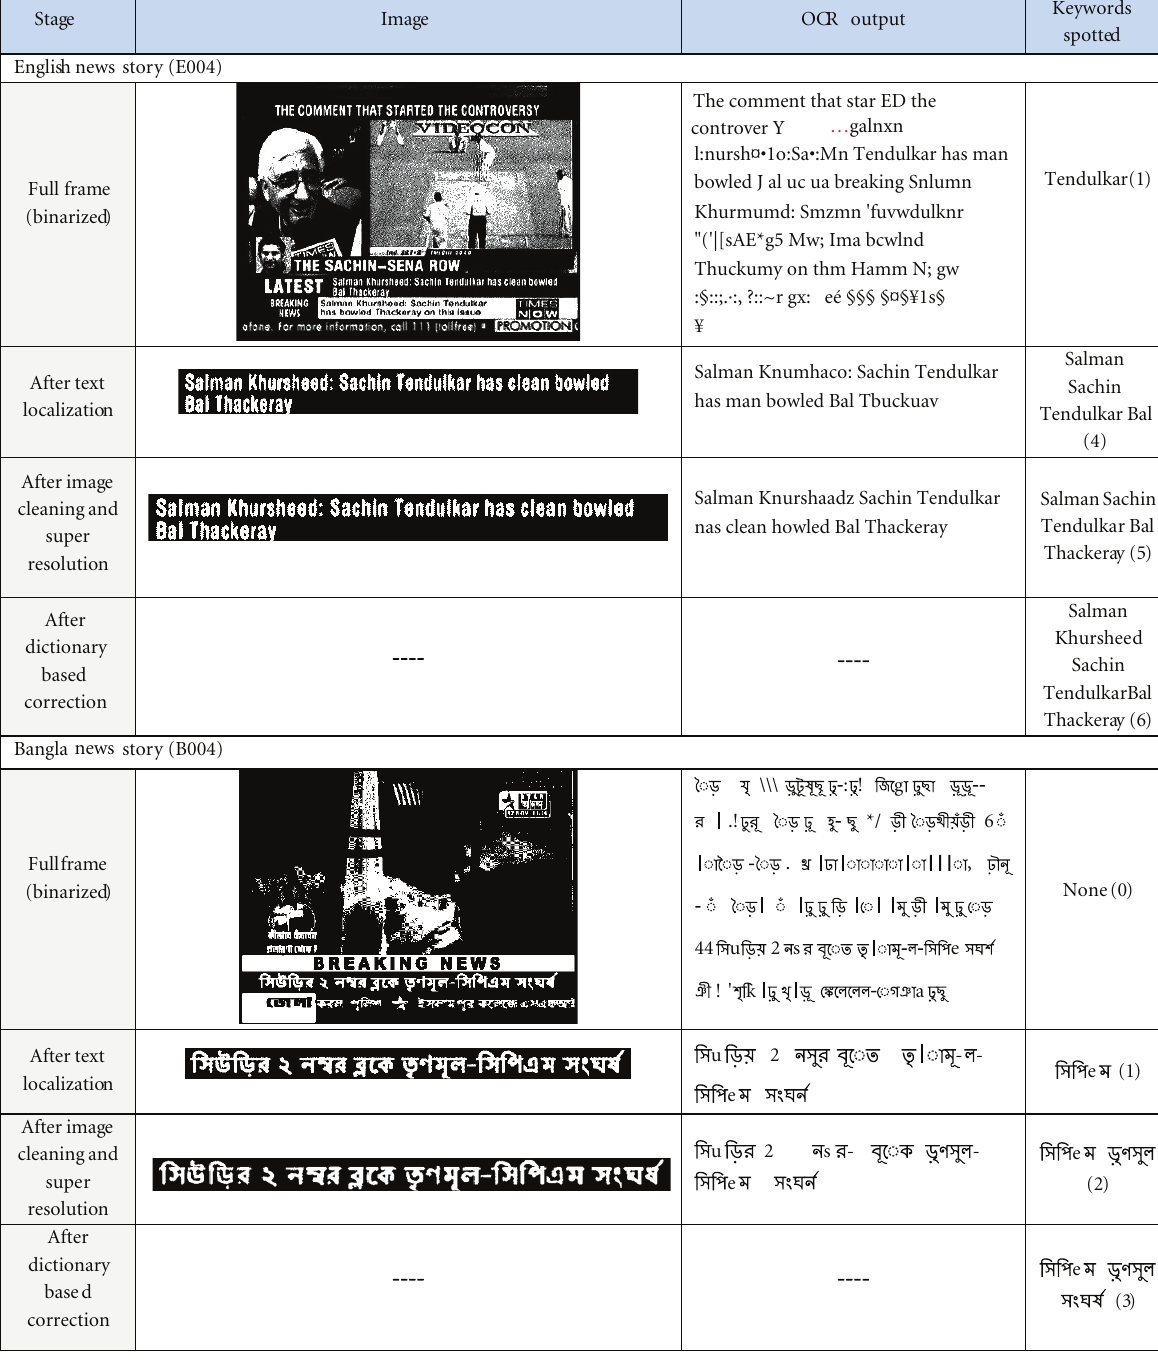
Figure 8: OCR outputs at di ff erent stages of English and Bangla ticker text